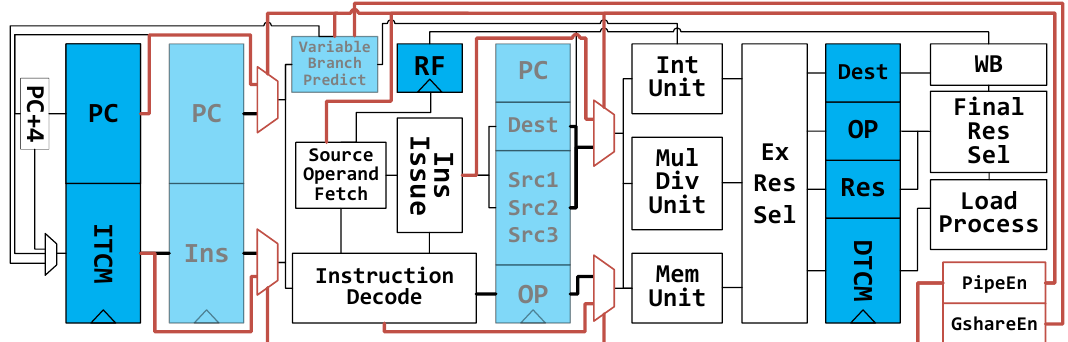
Figure 8. Variable architecture. Pipeline registers and branch predictor can be disabled in normal mode (N-mode) and low-power mode (L-mode). They are translucent in the